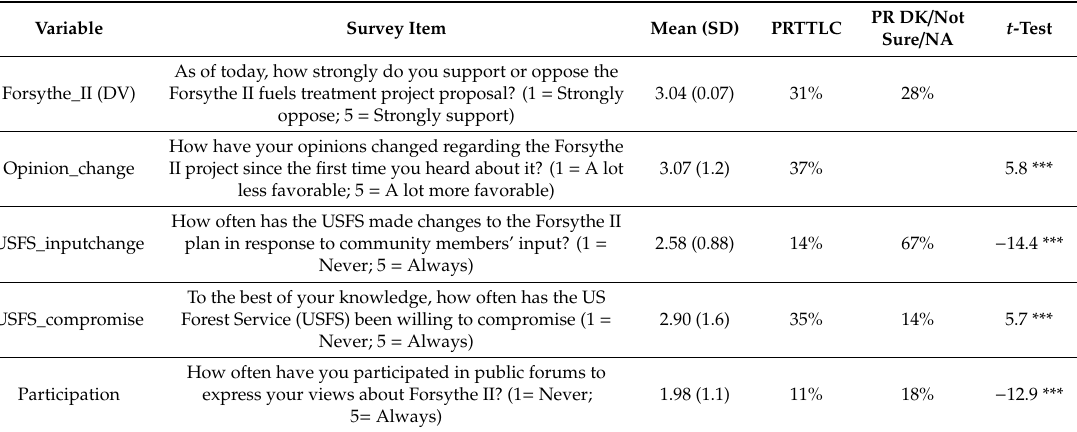
Table 3. Views on U.S. Forest Service (USFS) management of Forsythe